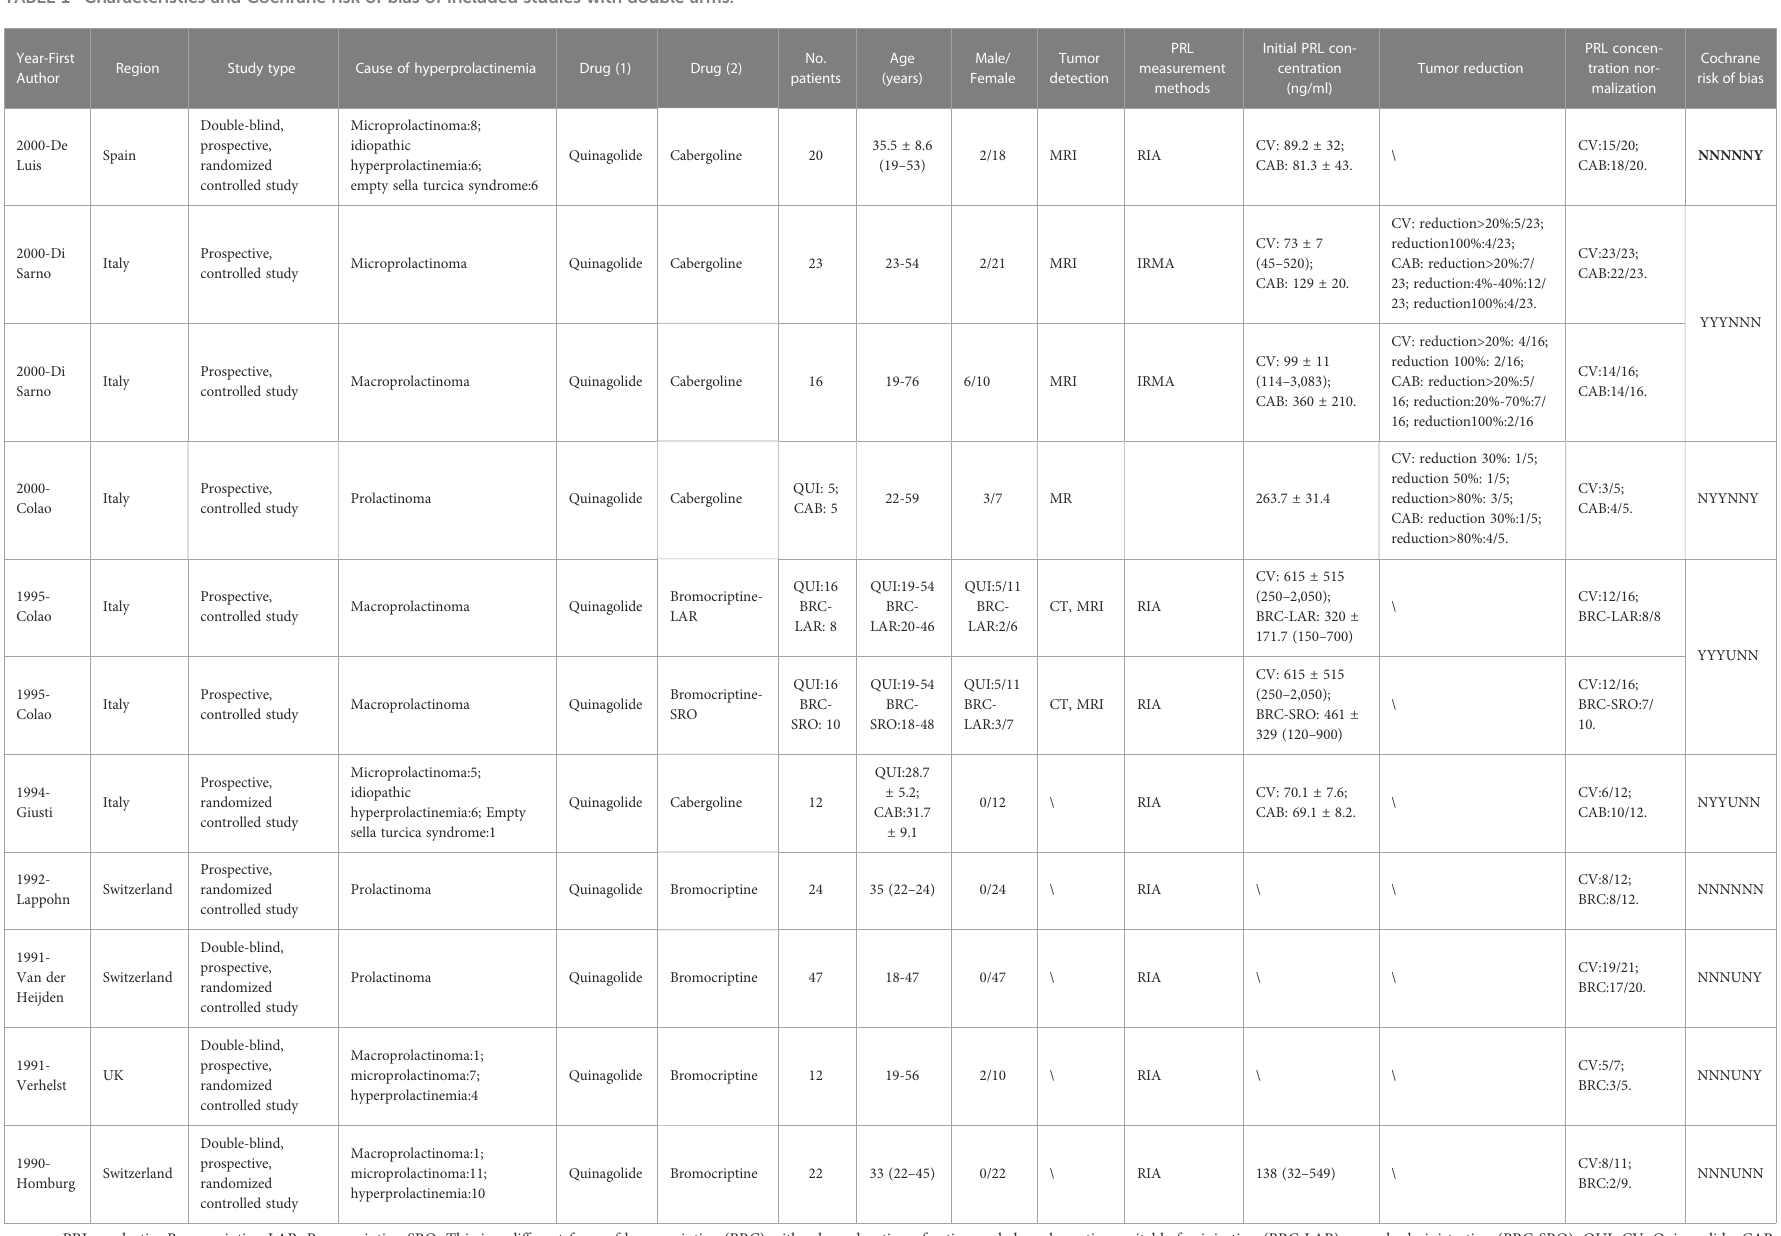
TABLE 1 Characteristics and Cochrane risk of bias of included studies with double arms.